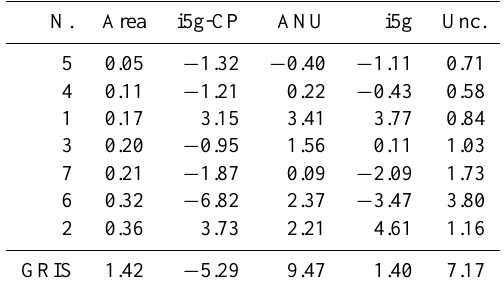
Table 5. GIA trends for Greenland. The first column is the basin number, the second its area (in 10 6 km 2 ) and from the third column the values are in Gt yr − 1 , and they report the values for the three models, namely ICE5g-VM2 compressible with rotational feed- back, ANU, and ICE5g-VM2 incompressible without rotation. The last column reports the maximum uncertainty among the models. The basins are sorted from the smallest to the